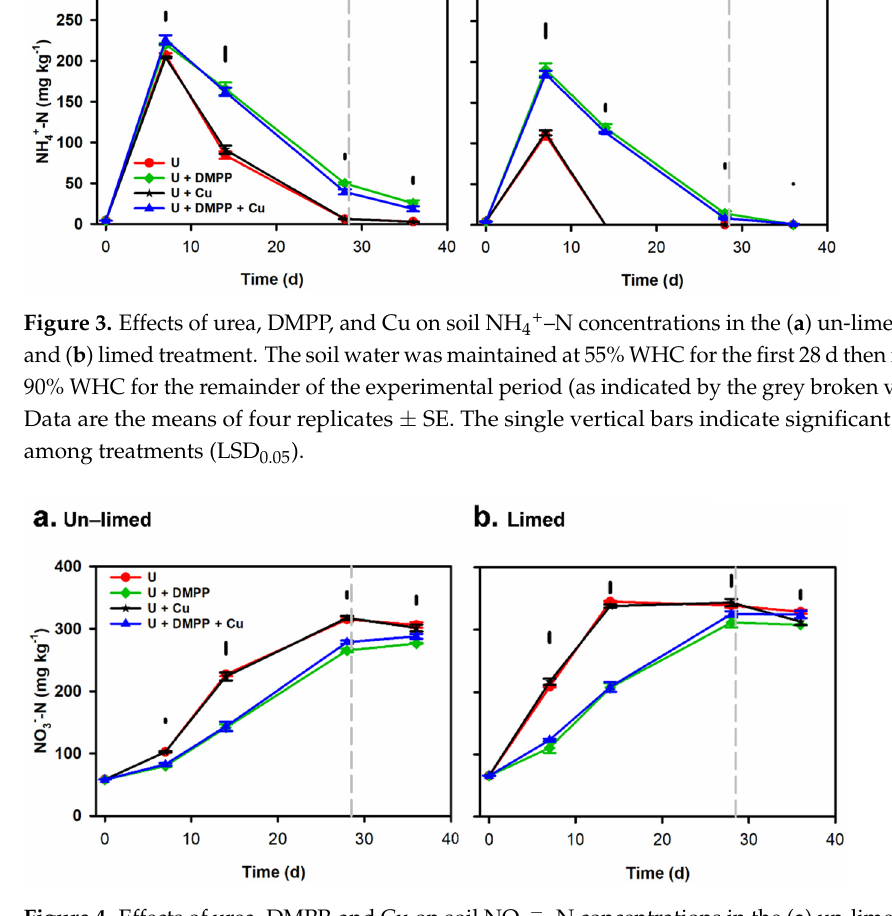
Figure 4. Effects of urea, DMPP, and Cu on soil NO 3 − –N concentrations in the ( a ) un-limed treatment and ( b ) limed treatment. The soil water was maintained at 55% WHC for the first 28 d then increased to 90% WHC for the remainder of the experimental period (as indicated by the grey broken vertical line). Data are the means of four replicates ± SE. The single vertical bars indicate significant differences among treatments (LSD 0.05).